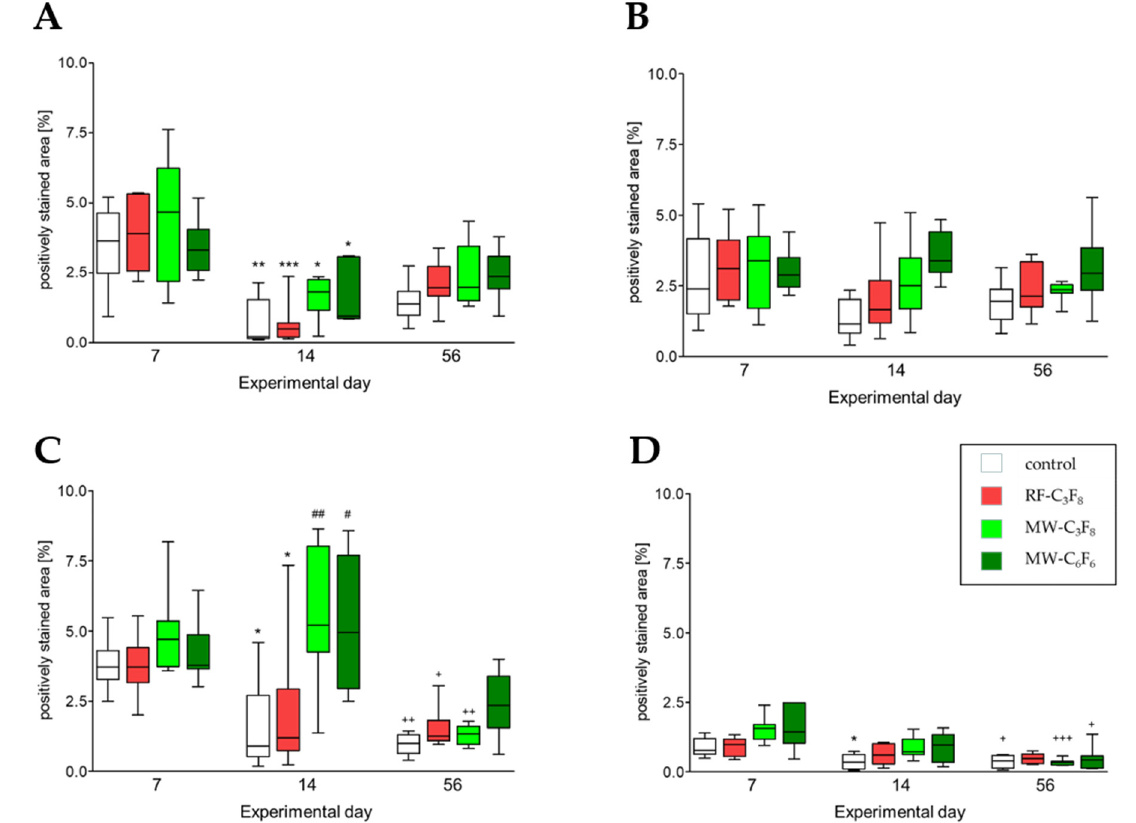
Figure 1. ( A – D ). Quantity of positively stained area of ( A ) pro-inflammatory CD68+ (ED1) monocytes/macrophages and ( B ) anti-inflammatory CD163+ (ED2) macrophages, ( C ) MHC class II+ antigen-presenting cells (OX6) and ( D ) nestin-positive cells (Rat 401) in the peri-implant tissue surrounding uncoated Ti6AI4V plates (white bars) and Ti6AI4V plates coated with the anti-adhesive plasma-fluorocarbon-polymers RF-C 3 F 8 (red bars), MW-C 3 F 8 (light green bars) and MW-C 6 F 6 (dark green bars) at days 7, 14 and 56 after simultaneous intramuscular implantation in rats. Boxes represent the median and interquartile range of eight rats per experimental day; p -values represent significant differences between experimental days. * p < 0.05, ** p < 0.01, *** p < 0.001 (day 7 vs. day 14), + p < 0.05, ++ p < 0.01, +++ p < 0.001 (day 7 vs. day 56), # p < 0.05, ## p < 0.01 (day 14 vs. day 56), Kruskal–Wallis test with Dunn’s post-hoc test.